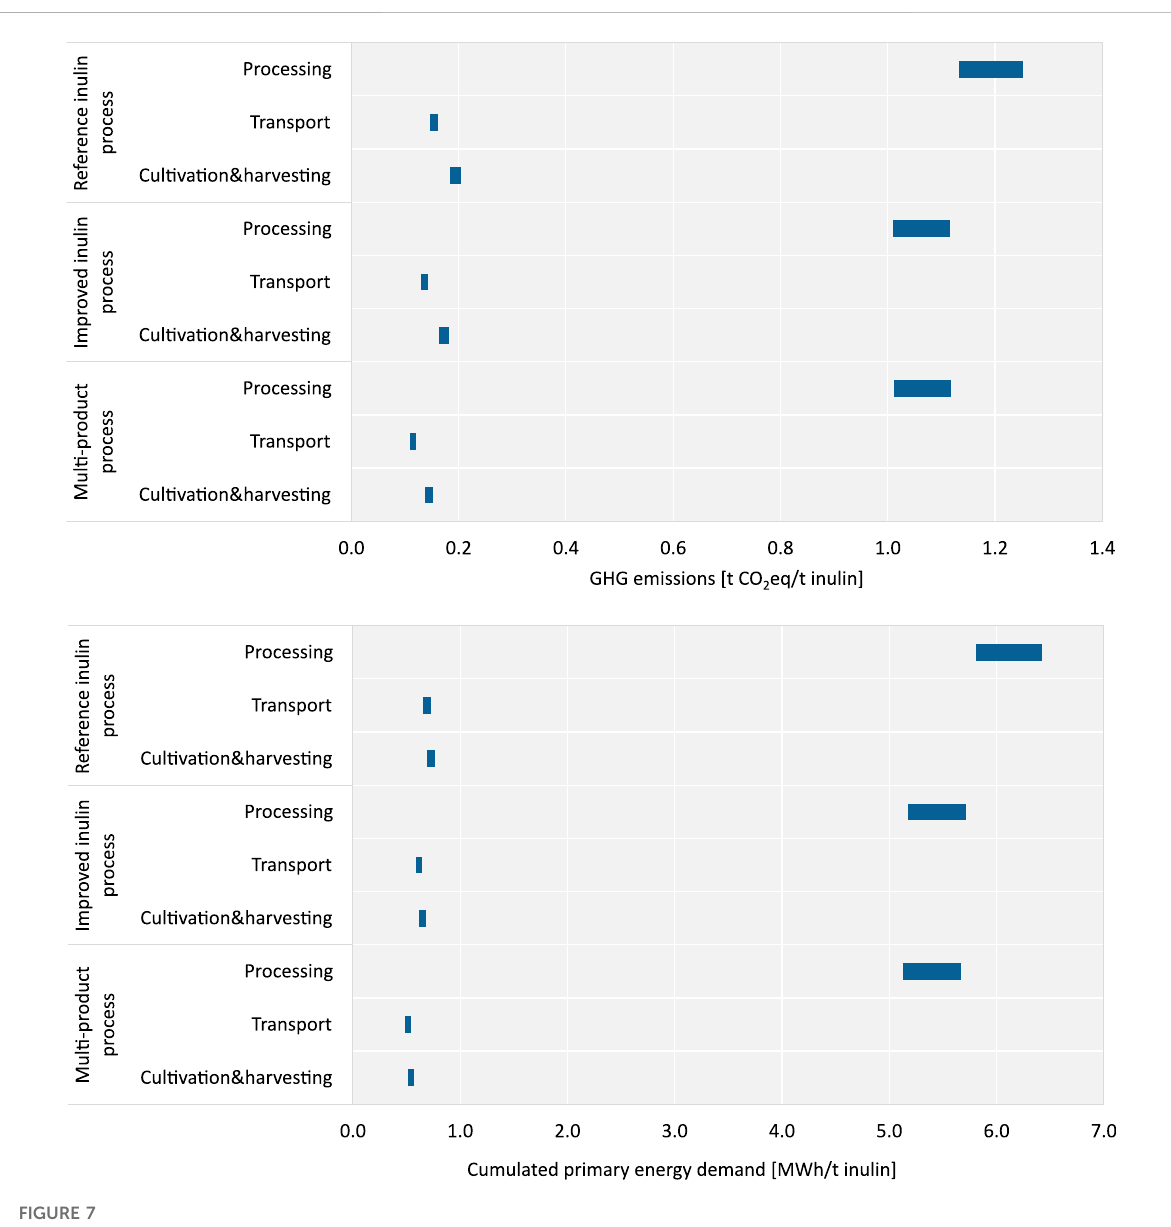
Frontiers in Genome